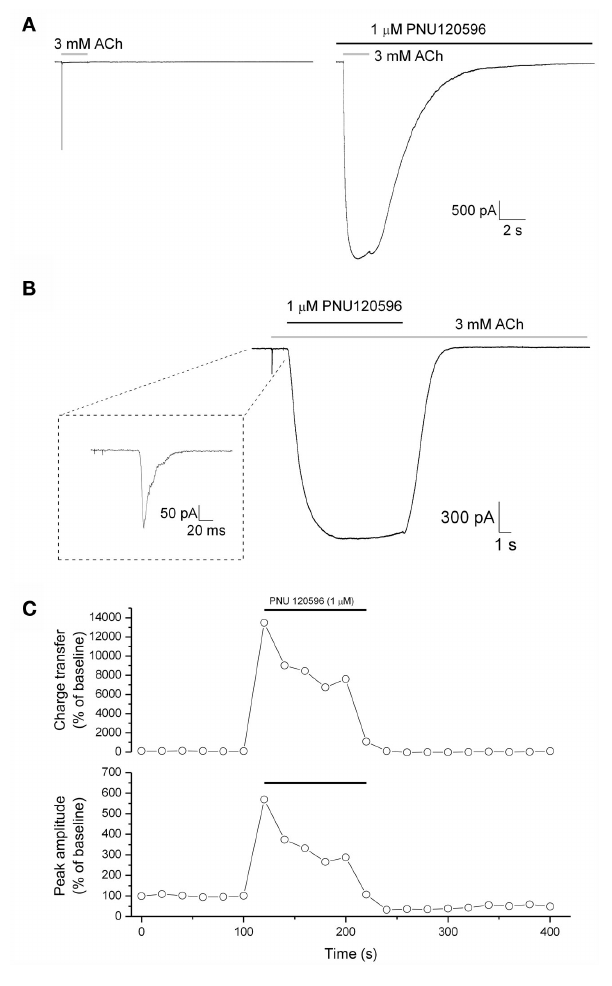
FIGURE 2 | Modulation ofACh-evoked currents by PNU120596. (A) Responses to ACh (3mM, gray bar; left) are increased in amplitude and kinetically modified in the presence of preapplied PNU120596 (1 μ M, black bar; right). (B) An example trace illustrating PNU120596-mediated dedesensitization. Receptors were initially activated and desensitized by ACh (3mM, gray bar) following which PNU120596 was applied in the maintained presence of ACh.The initial rapidly desensitizing ACh response is shown in the inset box. Following the removal of PNU120596 α 7 nAChRs redesensitize over several seconds. (C) The time course of responses to repeated ACh applications (3mM, 2s, every 20s) from a typical recording. Data for both response area (top) and peak amplitude (bottom) are shown, both normalized to the mean baseline value (as 100%). PNU120596 was continuously applied for the time indicated by the black